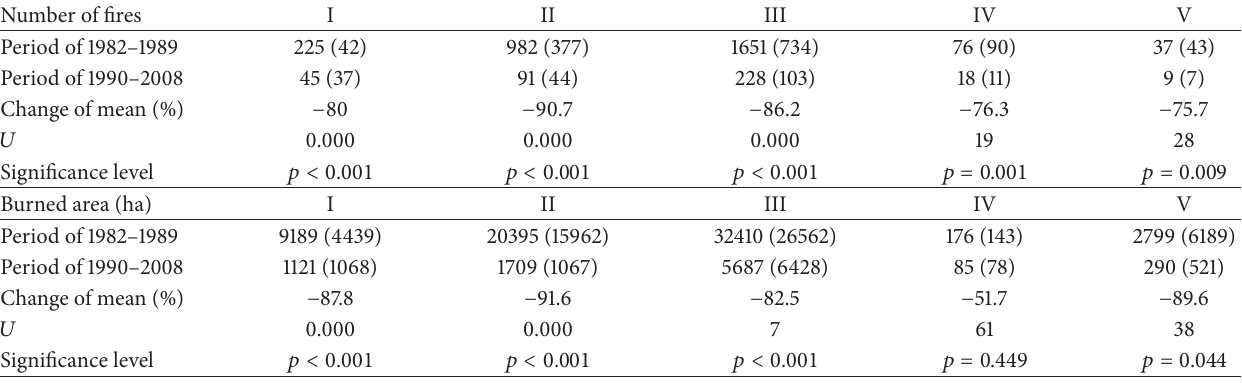
Table 2: Mann-Whitney 𝑈 test for the number of fires and area burned in Yunnan province during the two periods (1982–1988, 1989–2008).